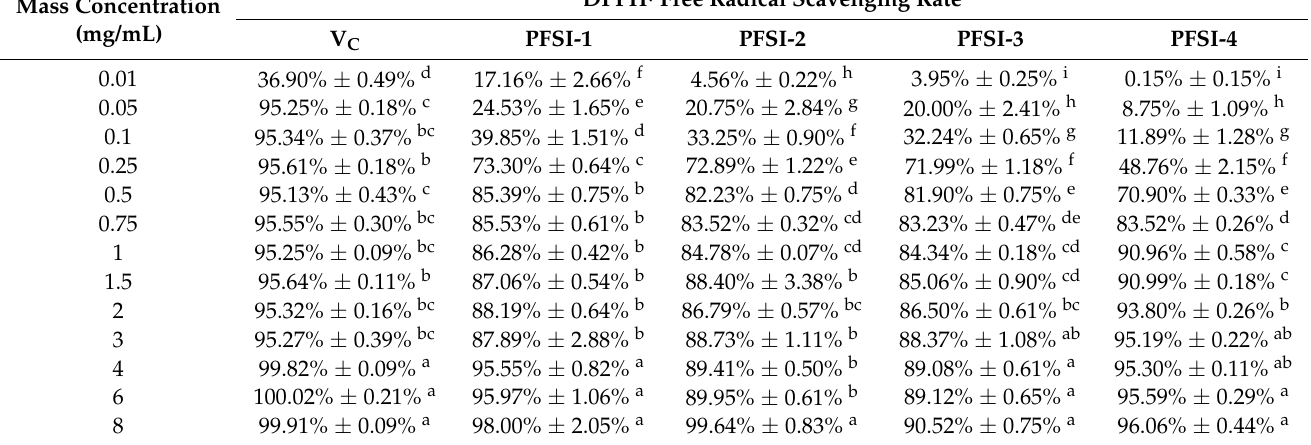
Table 4. DPPH free radical scavenging by PFSI-1, PFSI-2, PFSI-3, and PFSI-4. (Note: same lower- case letters indicate no significant difference between groups, different lowercase letters indicate a significant difference between groups, p <